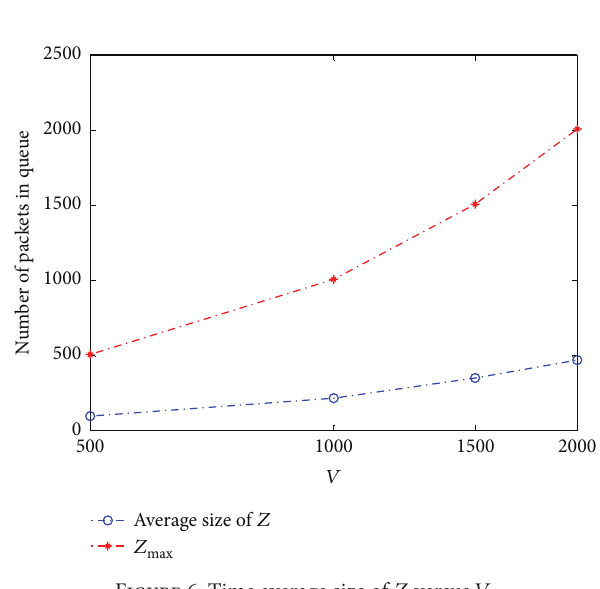
Figure 6: Time average size of 𝑍 versus 𝑉